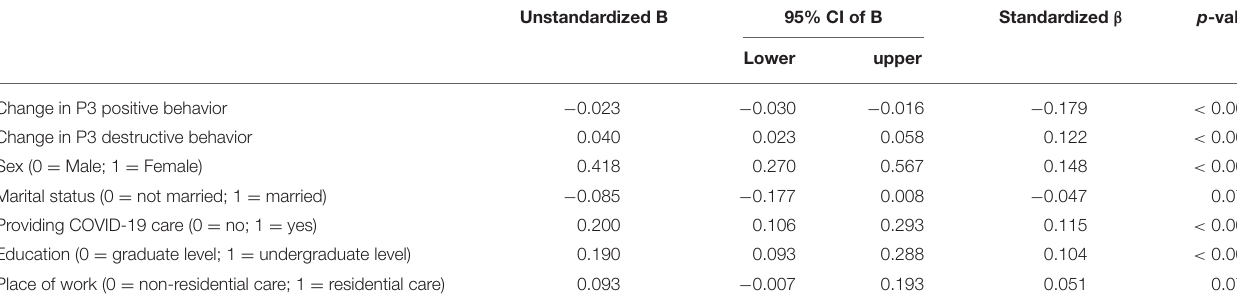
TABLE 5 | Multiple linear regression analysis investigating the influence of P3 behavior scores on